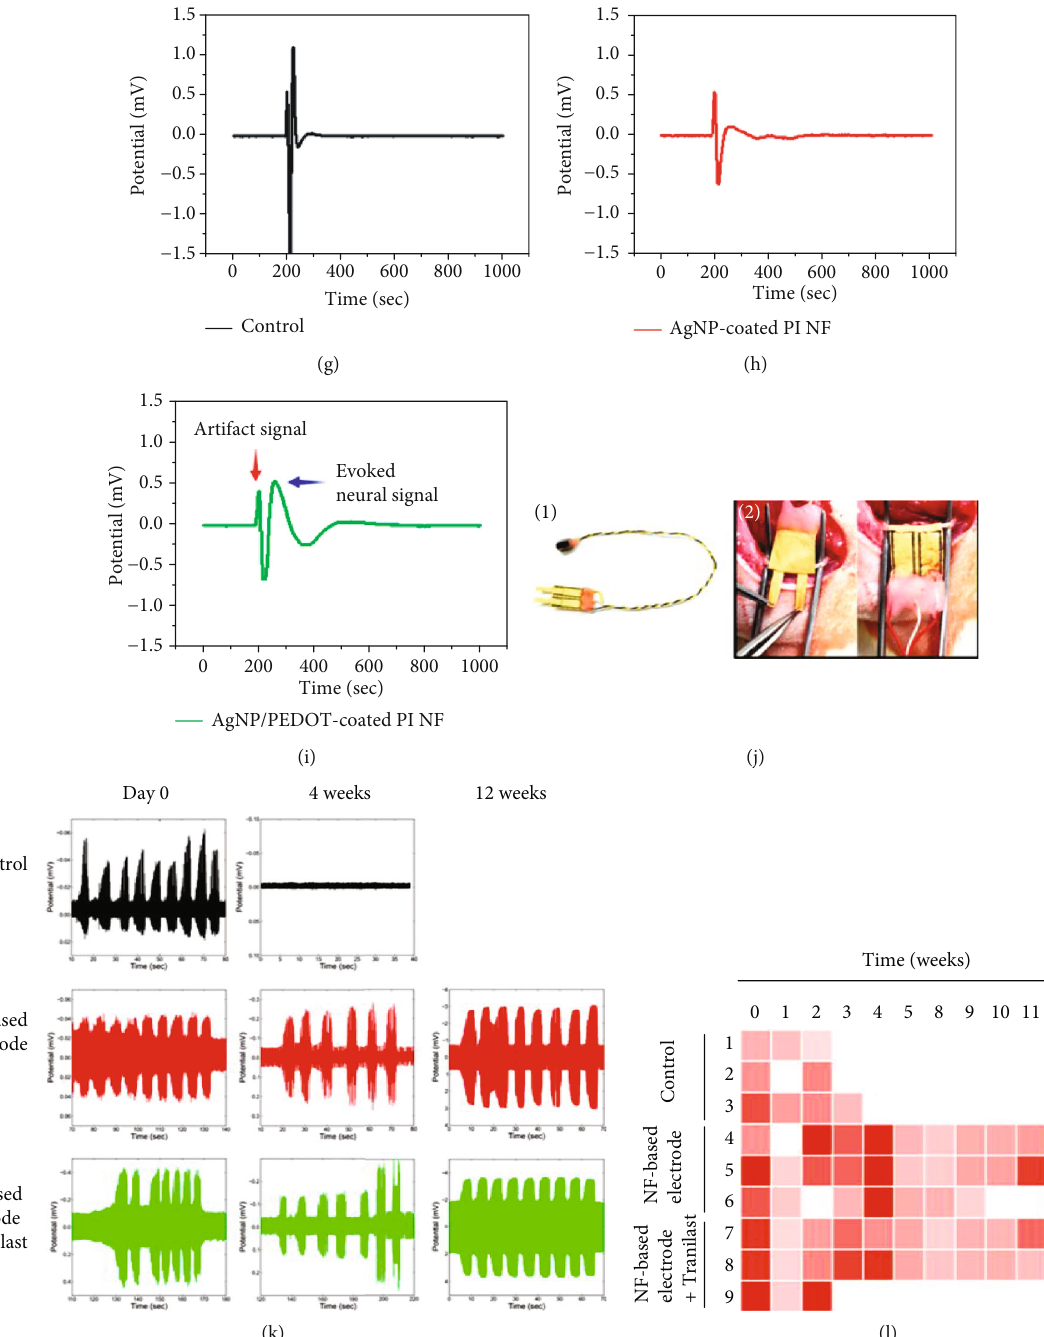
Figure 4: (a) Scheme of the fabrication process using an inkjet printing system. (b) Concept of preproduction design and (c) image of the fabricated NF-based neural electrode. Electric wire cables were bonded to the end of the electrode pads using conductive silver epoxy and were covered with bone cement. (d) Electrochemical impedance spectrum over a frequency range of 1 – 105 Hz. (e) Cyclic voltammograms with a scan range of − 0.7 to +0.8 V at a scan rate of 100mV/s. (f) Image of a wrapped stimulus cu ff electrode and a recording NF-based electrode. Acute ex vivo recordings obtained using (g) a control electrode, (h) AgNP-coated PI NF electrode, and (i) AgNP/PEDOT- coated PI NF electrode. (j) Electrical packaging electrode (1) and implanted electrode (2). The NF-based electrode is wrapped around the sciatic nerve of a rat. (k) Representative neural signal recording obtained from sciatic nerve tissue over a period of 12 weeks using a control electrode, an NF-based electrode, and an NF-based electrode soaked with Tranilast. (l) Simultaneous mapping of the SNR of an NF-based electrode with and without Tranilast